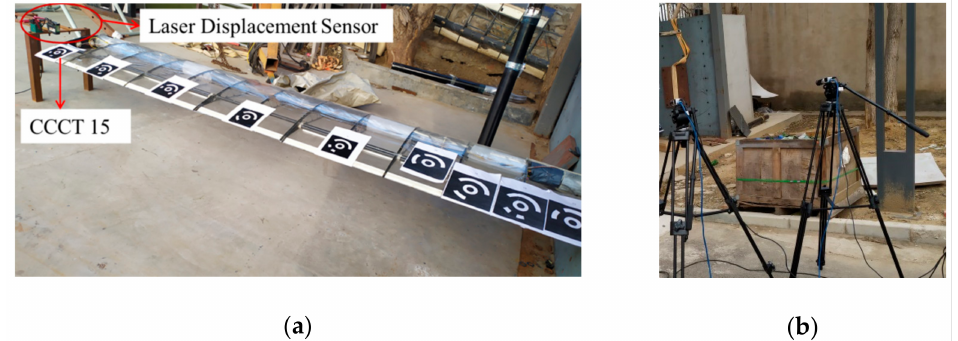
Figure 18. Wing deformation experiment using CCCTs in field work: ( a ) Binocular cameras; ( b ) laser displacement